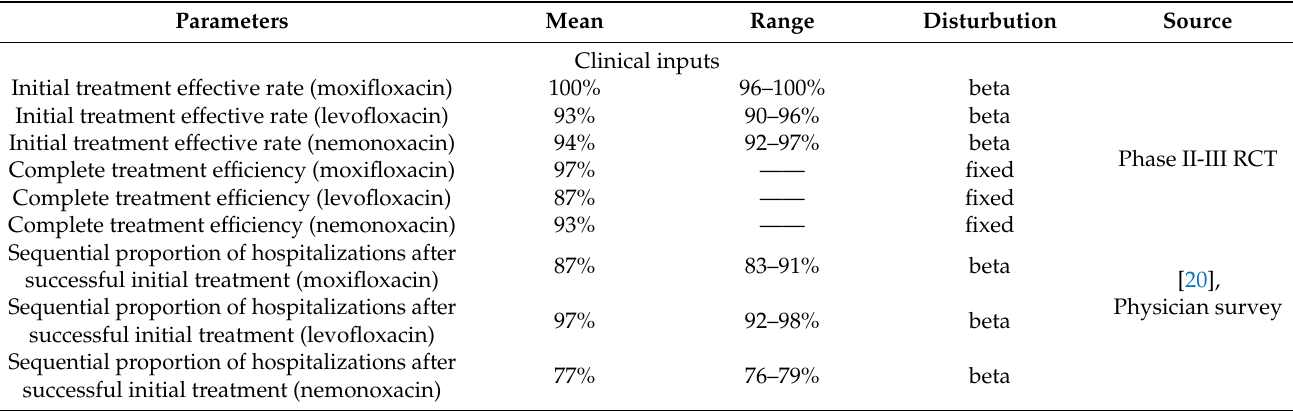
Table 1. Input parameters used in the